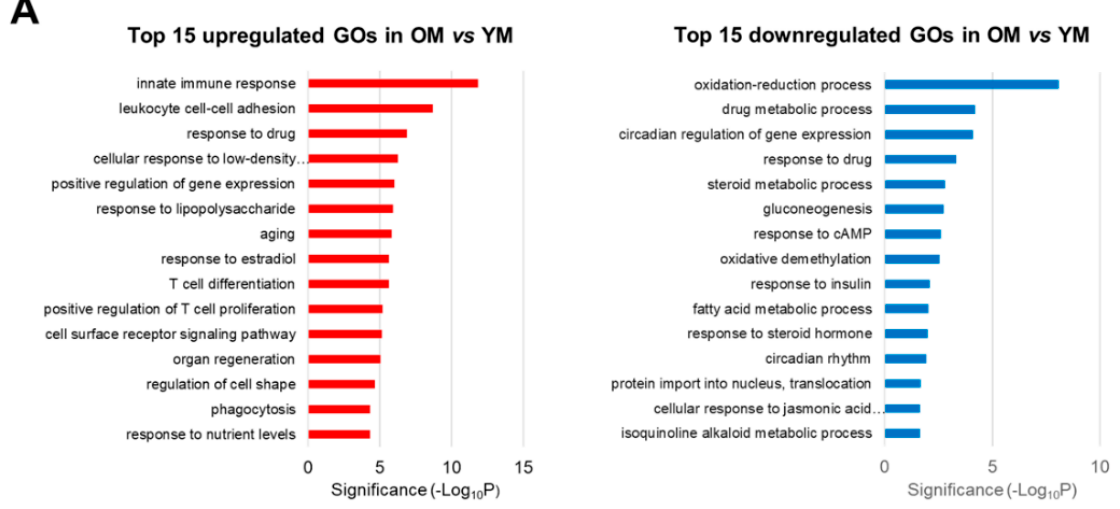
Figure 2. Age- and sex-differentially expressed genes from RNA-Seq data of ( A ) OM vs. YM, ( B ) OF vs. YF, ( C ) OM vs. OF, and ( D ) YM vs. YF from SD rats ( n = 3 in each group). Red dots represent upregulated genes between two groups. Blue dots represent downregulated genes between two groups. Grey dots represent genes that showed no change between two groups. The criteria for a DEG are |FC| > 1.5 and p -value < 0.05. OM, old male; YM, young male; OF, old female; YF, young female.